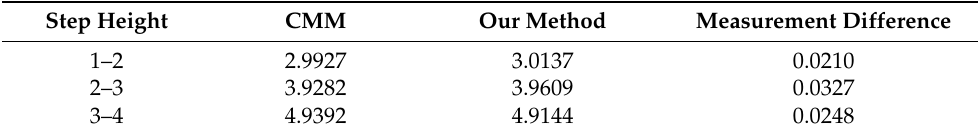
Table 2. The results and errors of the measured specular step (units: